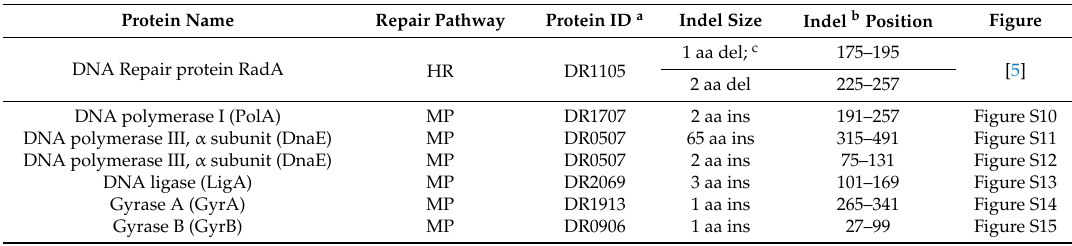
Figure S11 DNA polymerase III, α subunit (DnaE) Figure S12 DNA ligase (LigA) Figure S13 Gyrase A (GyrA) Figure S14 Gyrase B (GyrB) Figure